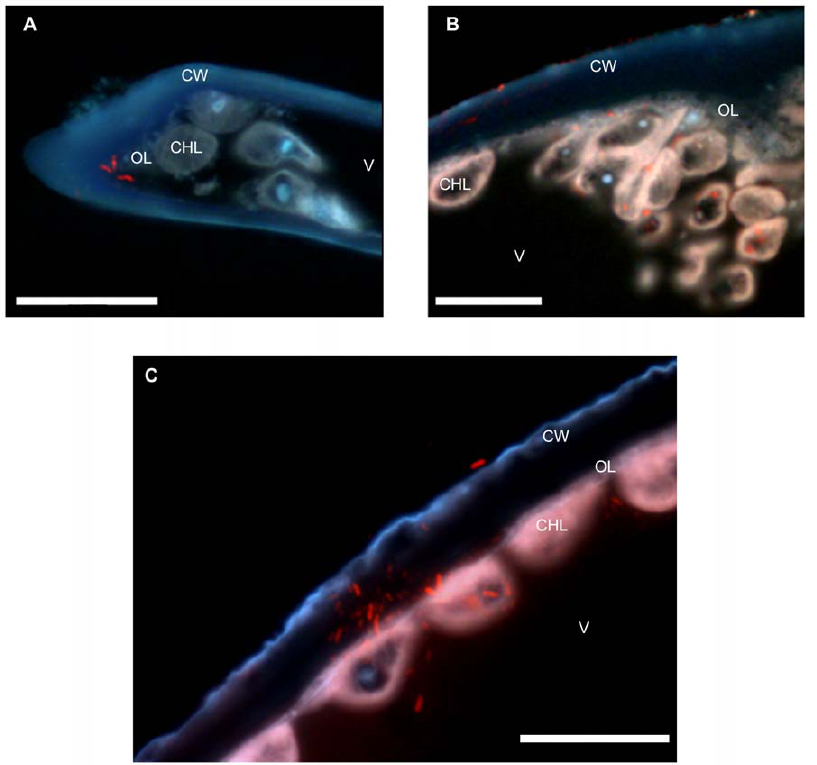
Figure 2. Epifluorescence microscopy images of Bryopsis sections hybridized with the universal bacterial Cy3-EUB338 probe mix (red). DAPI (light blue) and calcofluor (dark blue) were used as counter stains to visualize algal DNA in nuclei and chloroplasts and the algal cell wall, respectively. Metabolically active bacteria (red) are present throughout the Bryopsis cytoplasm: in the outer layer (OL) next to the cell wall (CW) which contains most of the organelles like mitochondria, endoplasmic reticulum, and nuclei (A–C), and in the inner chloroplast layer (CHL) immediately adjacent to the vacuole (V) (B–C). Since the Bryopsis thalli were not surface sterilized before fixation, the red probe also hybridized with epiphytic bacteria on the calcofluor stained cell wall (B–C). The scale bar on all images is 20 m